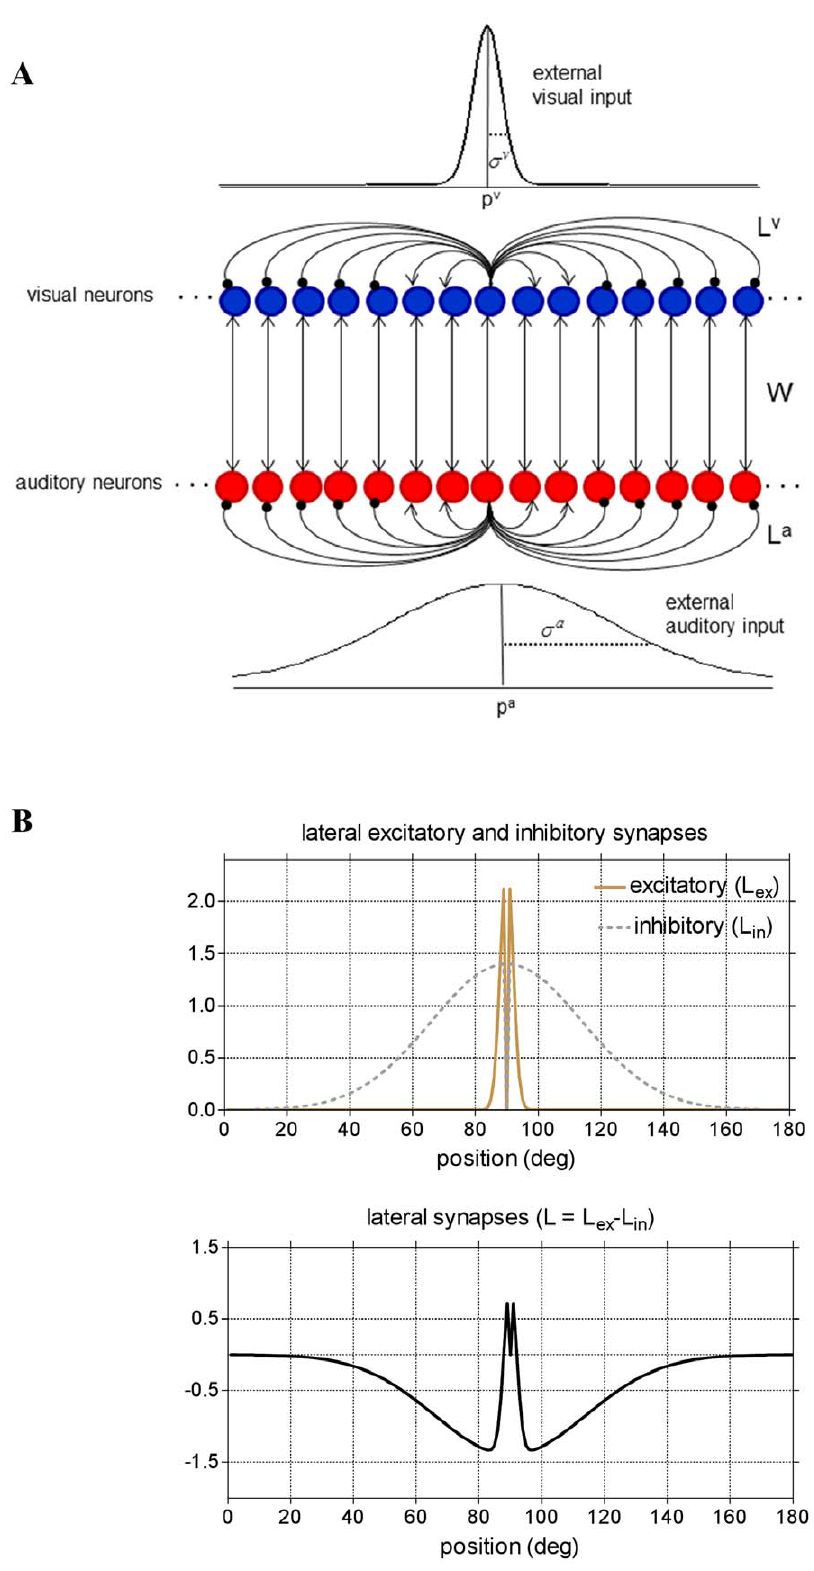
Figure 1. Overview of network architecture. ( A ) Schematic diagram of the neural network. Each red (blue) circle represents an auditory (visual) neuron. Each line represents a synaptic connection: lines ending with an arrow indicate excitatory connections; lines ending with a solid point indicate inhibitory connections. The Gaussian patterns mimic the external visual and auditory inputs; the Gaussian functions are centered at position p m ( m=v visual, m=a auditory), which represent the location of stimulus application, and have standard deviation s m and strength E m